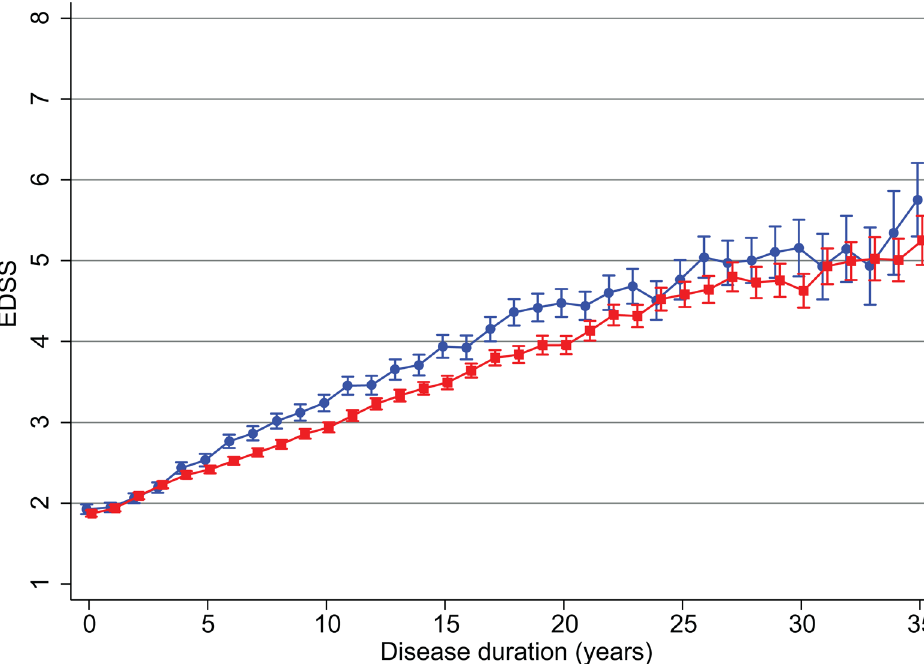
Fig 1. Mean value of EDSS for men and women with secondary progressive or relapsing remitting MS by number of years since initial EDSS. EDSS is shown as mean value ± SD. Disease duration was derived as the date of the visit at which the EDSS was determined minus the date of onset of MS symptoms. Red squares = females, blue circles = males.